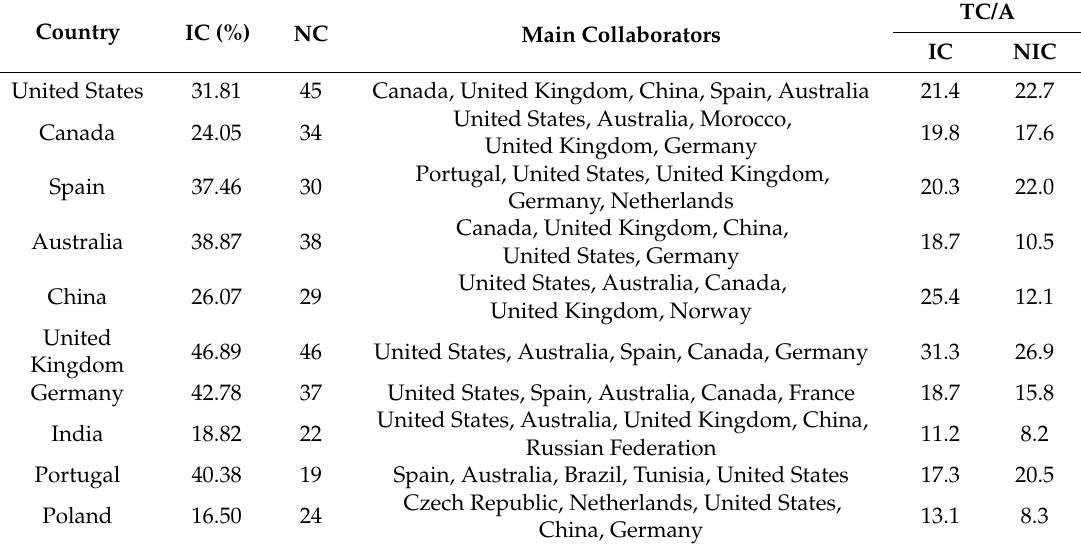
Table 4. International collaboration between the most productive countries in MW research.